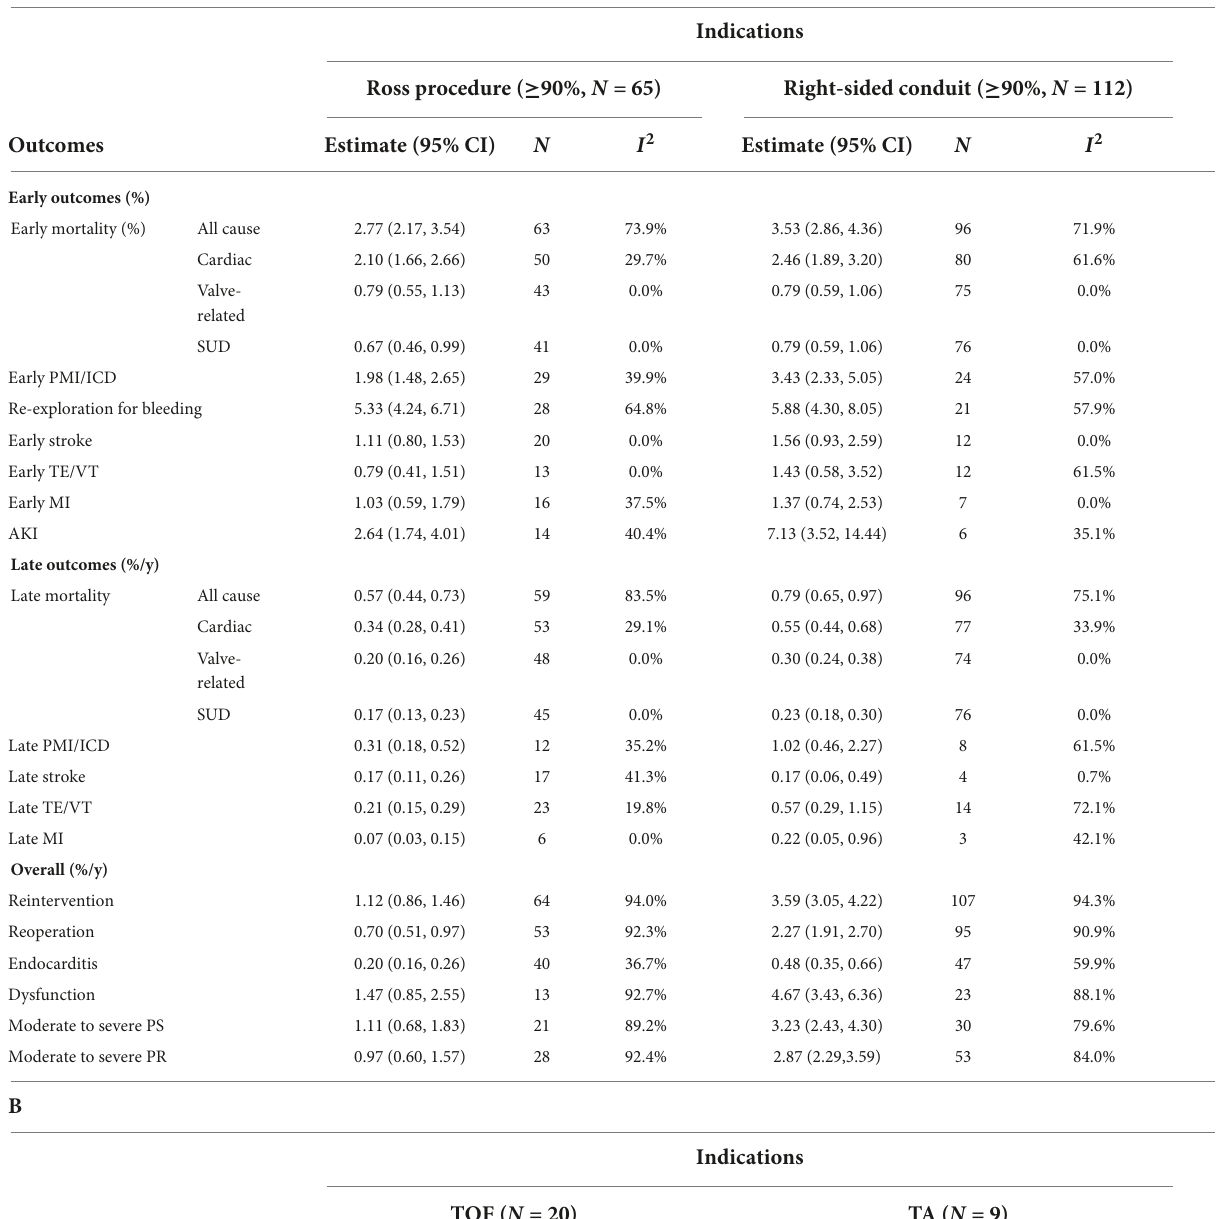
TABLE 3 Pooled outcomes of different